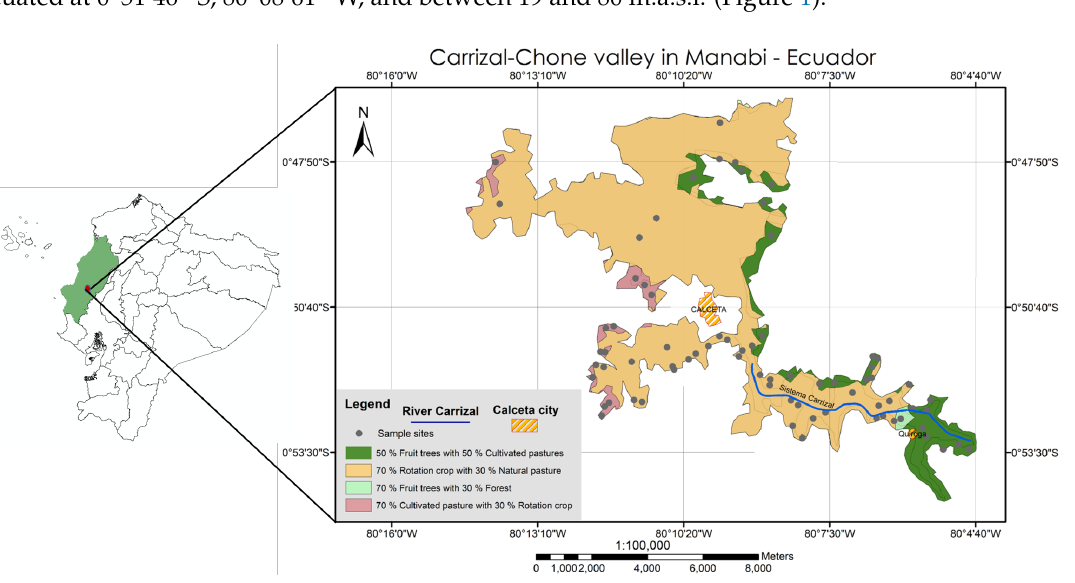
Figure 1. Area of study with the general land use in the Carrizal-Chone System (SCCH), Manabí, Ecuador. The average annual temperature of the area is 25.6 ◦ C, the average annual potential evapotranspiration is 1365.2 mm, and the average annual precipitation is 838.7 mm, with a dry period occurring from June to December, and a rainy period from January to May. The SCCH zone is composed of 50% natural pastures, 25% agricultural crops, 10% artificial pastures, 4% secondary forests, and 11% fallow, scrub, and